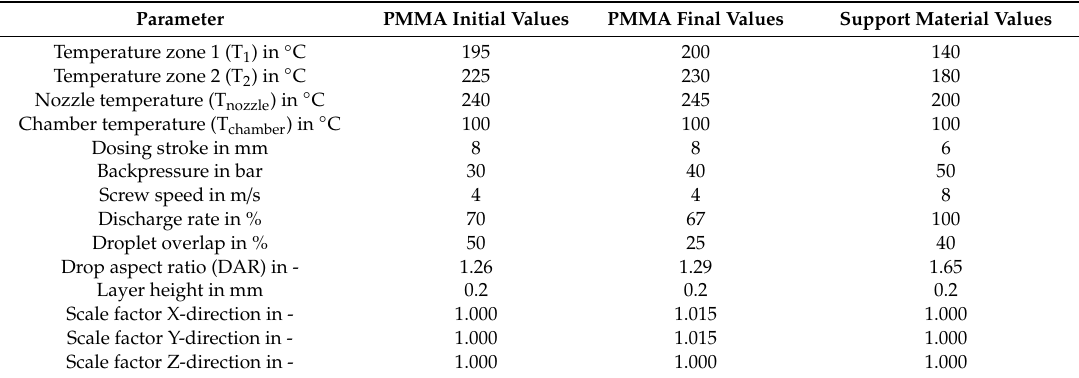
Table 2. Printing conditions for PMMA and the support material.